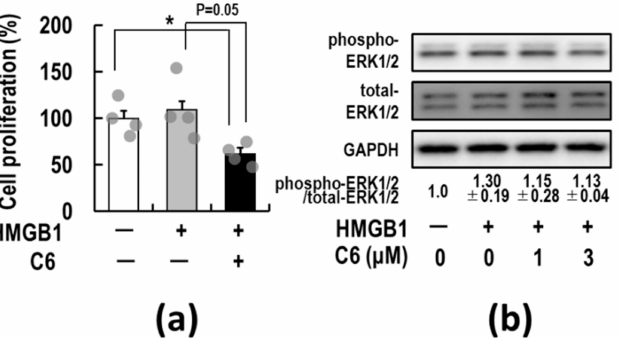
Figure 5. Suppressive effect of C6 on the HMGB1-stimulated activation of ERK1/2 in HCT116 cells. ( a ) HCT116 cells were pre-treated with 3 µ M C6 for 2 h and then stimulated with 10 µ g/mL HMGB1 or vehicle (phosphate-buffered saline) for 72 h. The relative cell proliferation rate (%) was measured using trypan blue exclusion assay as described elsewhere in Section 4 and represents the mean ± SE of four independent experiments. p values were calculated against vehicle control with the Student’s t -test. * p < 0.05 was accepted as a significant difference. ( b ) HCT116 cells were pre-treated with 3 µ M C6 at indicated concentrations for 2 h and then stimulated with HMGB1 (10 µ g/mL) for 30 min. Cell lysates were subjected to Western blotting using phospho-ERK1/2 and total ERK1/2 antibodies as described in Section 4. GAPDH served as a loading control. The panels depicted a typical immunoblot. The values are the ratios of each phospho-ERK1/2 to total-ERK1/2 band intensities calculated by densitometric analysis. Values represent the mean ± SE of three independent experiments. The original image of Figure 5b is shown in Supplementary Figure